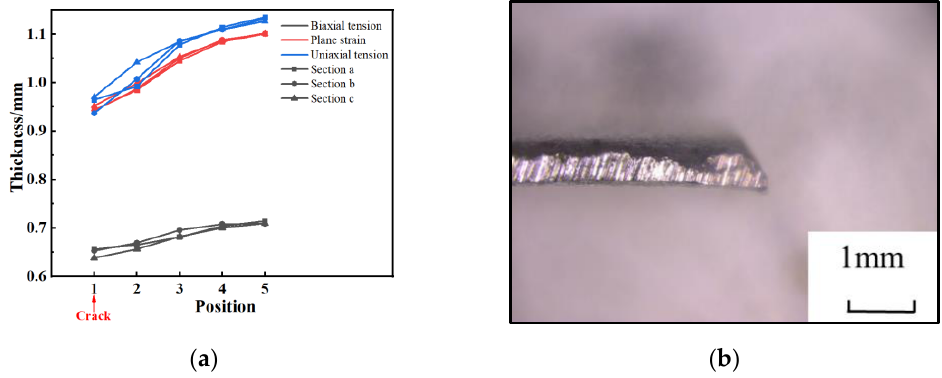
Figure 15. The thickness distribution of different tests and the observation of the crack edge of balanced biaxial tension specimen: ( a ) thickness distribution of different section cuts and locations; ( b ) the observation of the crack edge.